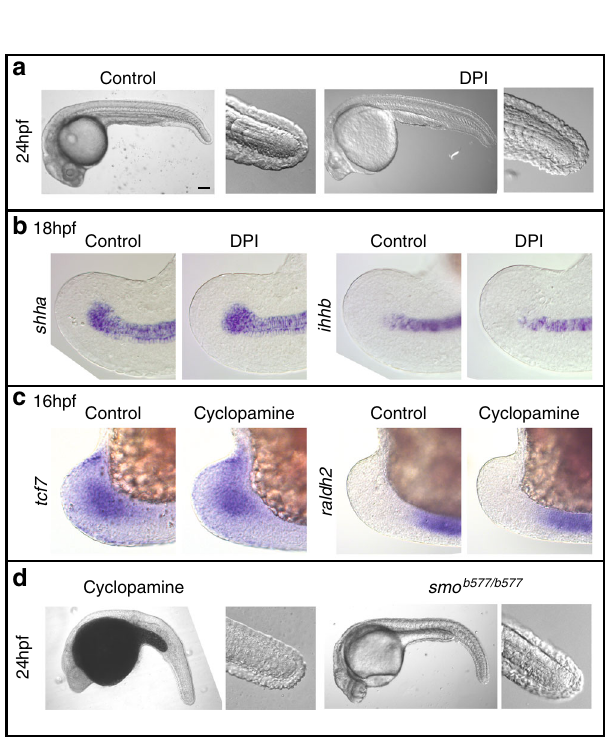
Fig. 7 ROS and Hedgehog signalling do not have similar roles during tail development. a DPI treatment at 100 μ M from 14 to 24 hpf does not affect larval tail morphology (10/10, number of experiments = 3). Scale bar is 200 μ m. b shha and ihhb expression in the tail is not affected by DPI treatment at 100 μ M from 14 to 18 hpf (20/20 for all panels, number of experiments = 2). c tcf7 and raldh2 expression in the tail bud is not affected by treatment with 20 μ M cyclopamine from 8 to 16 hpf (20/20 for all panels, number of experiments = 2). d Loss of Hedgehog signalling does not affect tail formation. Larvae were treated with 20 μ M cyclopamine from 8 to 10hpf (10/10, number of experiments = 2). Homozygous smo b577 mutants (7/7, number of experiments = 2) lack zygotic Hedgehog signalling activity. Embryos were manually dechorionated prior to